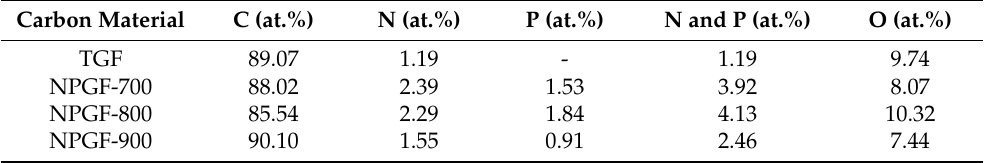
Table 1. Element concentration of TGF, NPGF-700, NPGF-800, and NPGF-900. Carbon Material